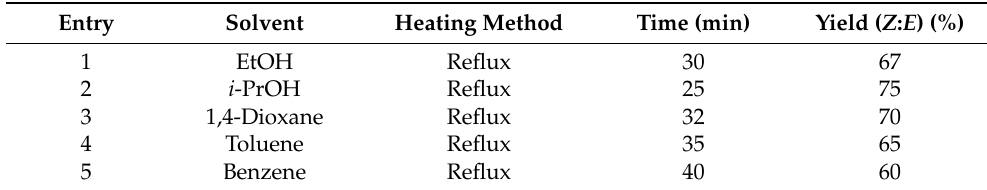
Optimization of the reaction conditions for 5-(4-chlorophenyl)-3-[(pyridin-2- ylamino)methylene]furan-2(3 H )-one 9a